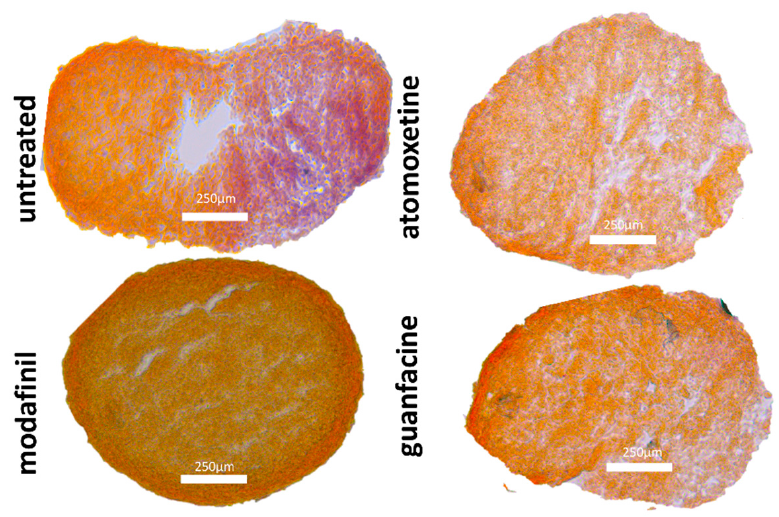
Figure 7. Alizarin red stained images of untreated, modafinil (11.2 µ g/mL)-, atomoxetine- (0.9 µ g/mL) and guanfacine- (17.7 ng/mL) treated MG63 spheroids. Three independent experiments with six biological replicates were carried out. Scale bar 250 µm.